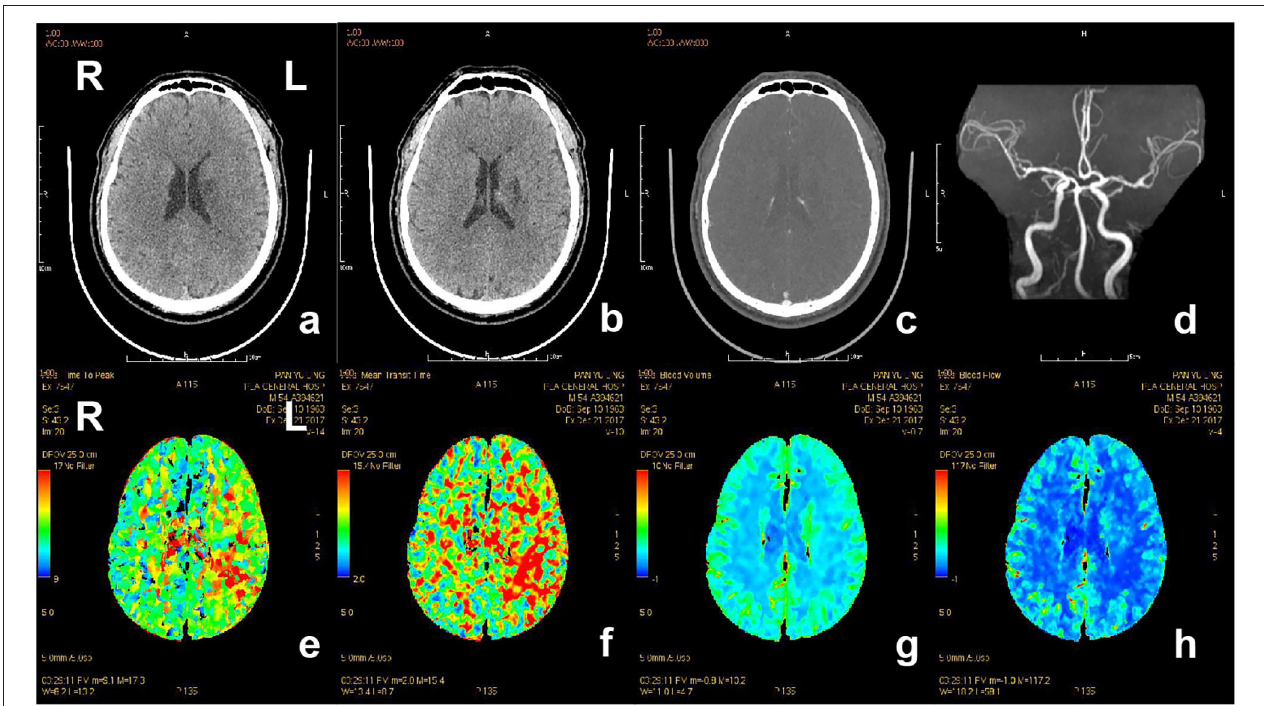
FIGURE 4 | CT and CTP imaging of the patient with acute ischemic stroke. The patient, 80-year-old-female, suffered from weakness of right limbs, alalia and was unable to walk 3.5h prior to the imaging. Medical history included hypertension, atrial fibrillation and gout. Physical examination showed right facial paralysis, the muscle strength of right limbs was grade I, right Babinski sign ( + ), and NIHSS score was 10. The diagnosis of the patient is acute ischemic stroke. The patient was given multimodal CT and MRA before recanalization. a and b, The left bilateral basal ganglia and bilateral frontal lobe showed sporadic dots and patches with low-density shadow on non-contrast CT scan. c, Contrast-enhanced CT showed no abnormal enhanced shadow. d, MRA showed the lumen of bilateral middle cerebral artery was not smooth, the left cerebral artery M1 segment had multiple stenosis, and distal branch vessels were disappeared. e and f, Prolonged TTP and MTT in the area of left middle cerebral artery. g and h, CBF and CBV showed no significant abnormal area. CT, computed tomography; CTP, computed tomography perfusion; CBV, cerebral blood volume; CBF, cerebral blood flow; TTP, time to peak; MTT, mean transit